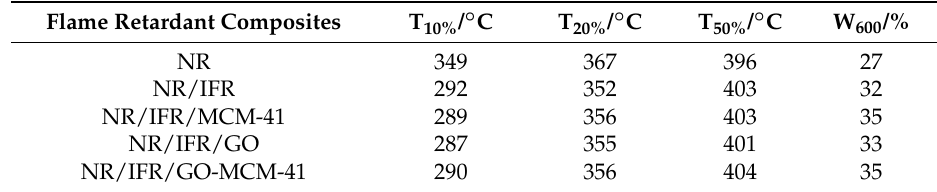
Figure 7. DTG curves of NR and FRNR composites. Table 4. TG data of FRNR